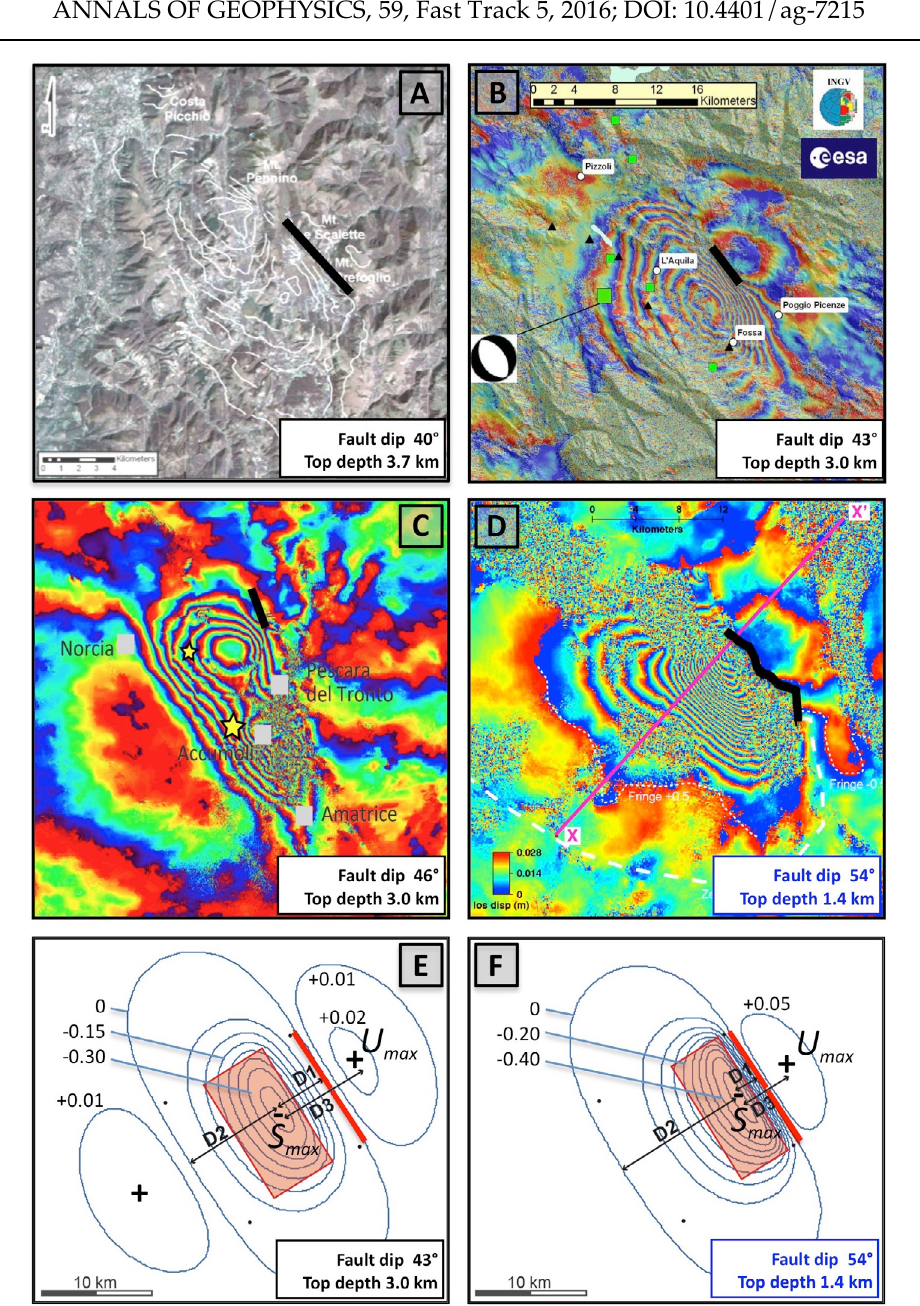
Figure 2 . Panels A-D: comparison of InSAR models. (A) 1997 Colfiorito earthquake [Moro et al. 2007]; (B) 2009 L’Aquila earthquake [ESA, 2009]; (C) 2016 Amatrice earthquake, solution obtained from Sentinel-1 data [Gruppo di Lavoro IREA & INGV 2016]; (D) 1995 Dinar, Turkey earthquake [Douglas and Funning 2016]. The observed or presumed – depending on cases - surface expression of the fault is shown by a thick black line. Panels E-F: comparison of the "coseismic signature" obtained for two distinct model faults, showing the extent of coseismic uplift and subsidence per unit slip: (E) is an average of the models obtained for the 1997, 2009 and 2016 earthquakes, (F) reproduces the 1995 Dinar earthquake. A thick red line shows the surface projection of the fault plane. See also Tables 1 and